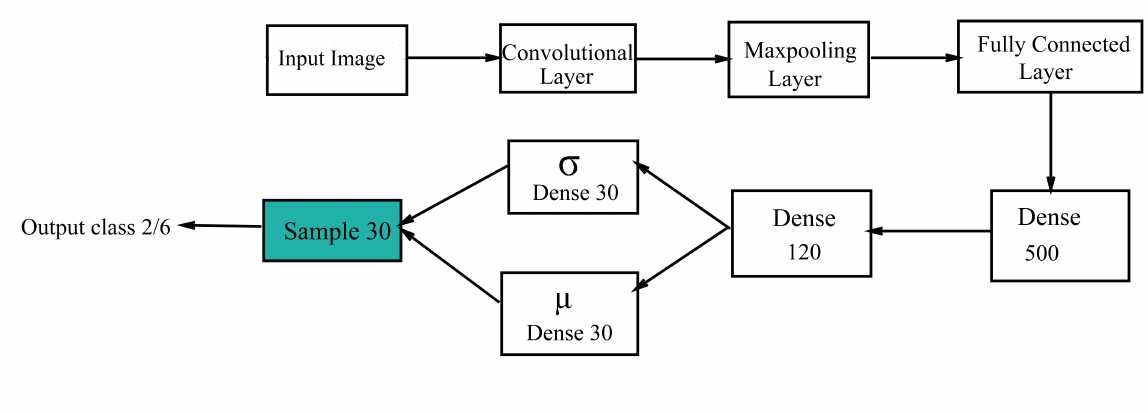
Figure 4. Variational Autoencoder + Convolutional Neural Network (VAE-CNN)